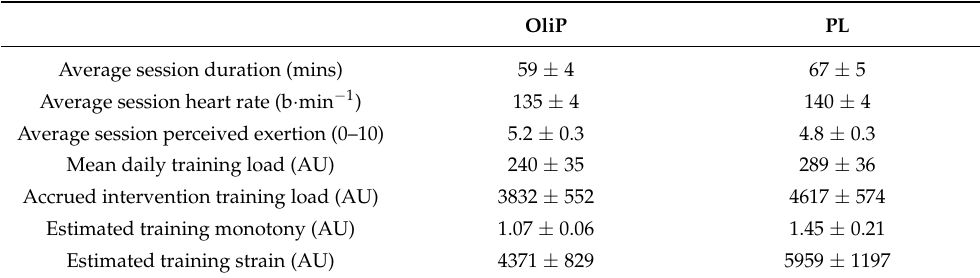
Table 3. Estimated exercise activity and training load parameters across the 16-day intervention period for those consuming OliPhenolia ® (OliP) or a matched placebo (PL). OliP PL Average session duration